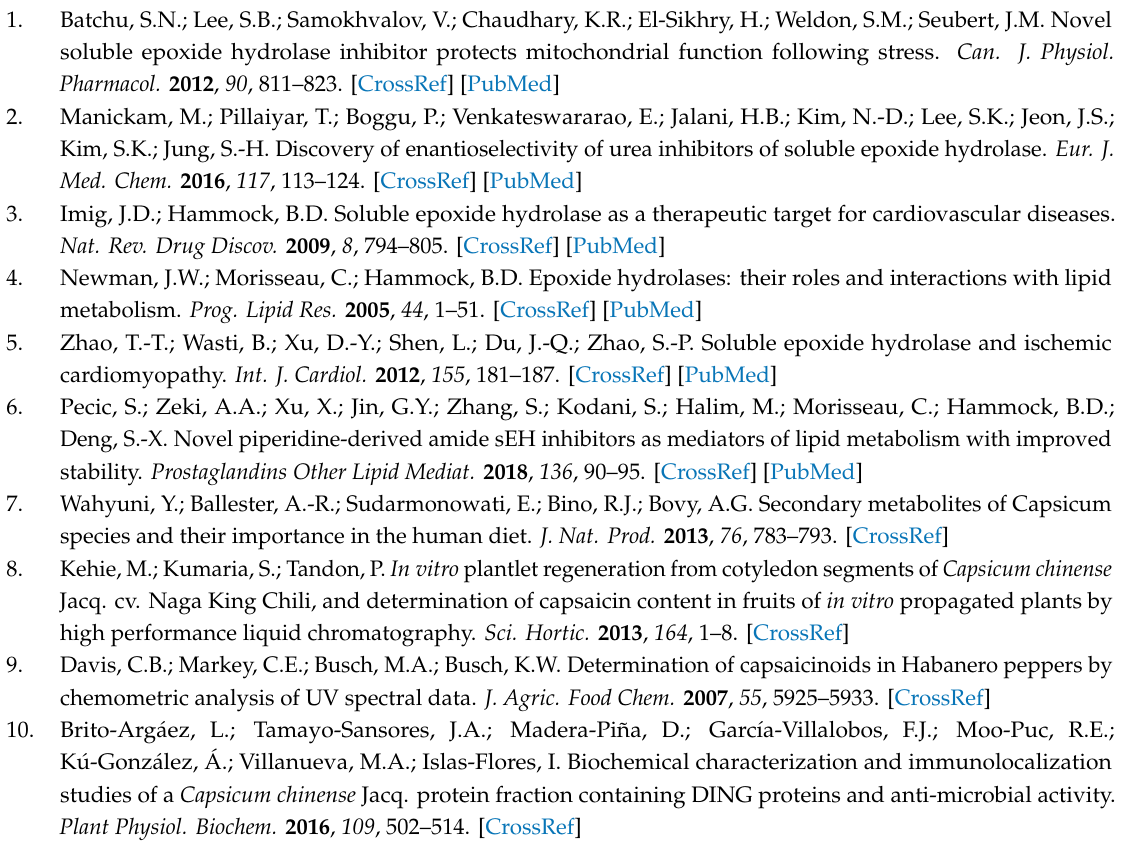
Figure S1–S3: 1 H- NMR and 13 C-NMR spectra of compounds 1 – 3